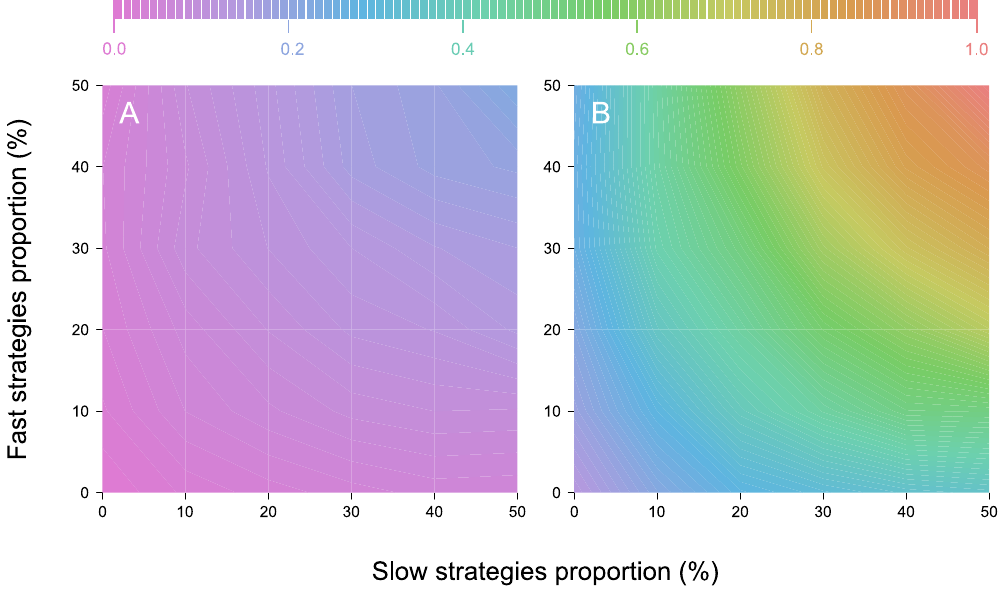
Figure 4. Predicted phenological variance (colours) for populations with different compositions of pace-of- life strategies (slow-fast developmental rates). Simulations were performed using Model 2B, with a virtual ectotherm species showing four ( A ), and eight ( B ) life stages. Development rates were generated under constant temperatures. Each value for the combination of slow and fast strategies represent the mean of 30 runs with 100